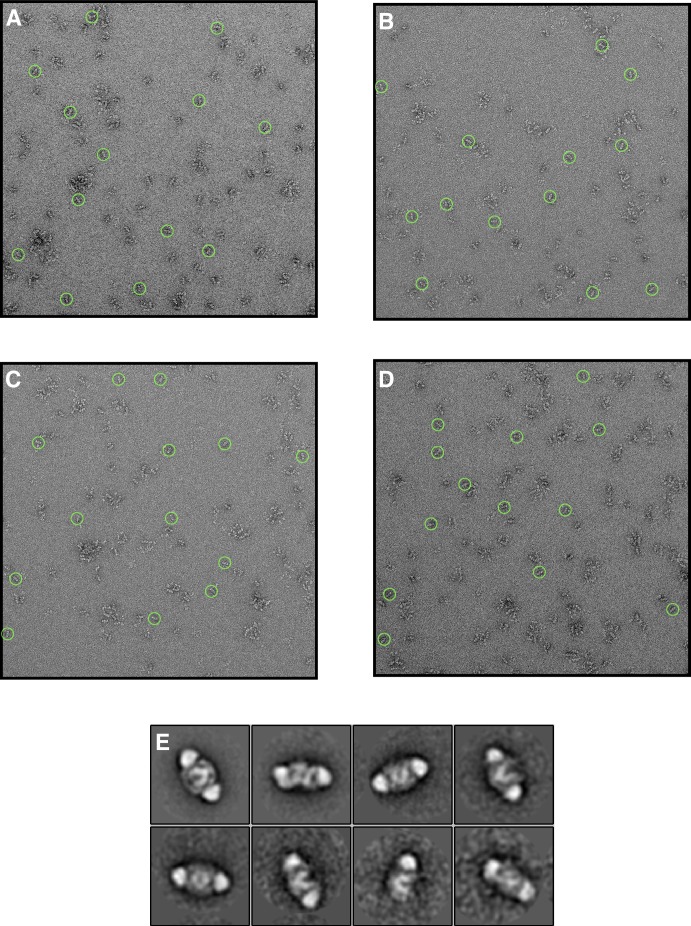
Negative stain EM of SNF2h in the presence of ADP-BeFx and 140 mM KCl.(A–D) Raw micrographs of negatively stained sample performed under the same buffer conditions as the dataset in Figure 1. Complexes were assembled identically to the high resolution EM condition and then diluted 40-fold in buffer immediately before applying the sample to the grid to permit visualization by negative stain EM. The final concentration applied to the grid was 15 nM nucleosomes and 31 nM SNF2h. Examples of monodisperse particles are circled; (E) Selected class averages from (A–D) showing that in these conditions, the majority of nucleosomes are doubly-bound.